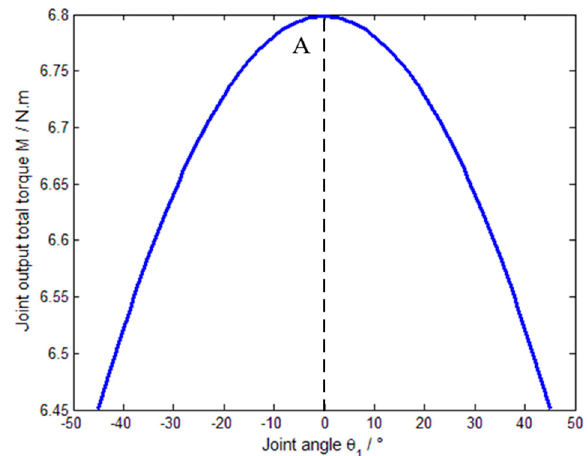
Figure 5. Relationship between joint angle θ 1 and M under different values of θ 1 .